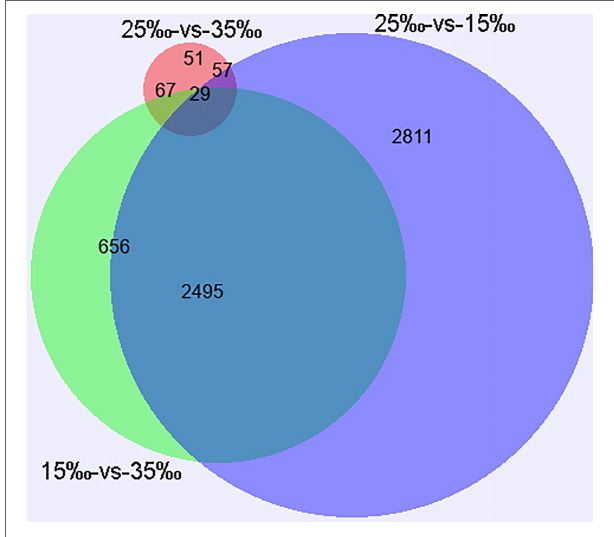
FIGURE 2 | Global overview of DEGs based on Venn